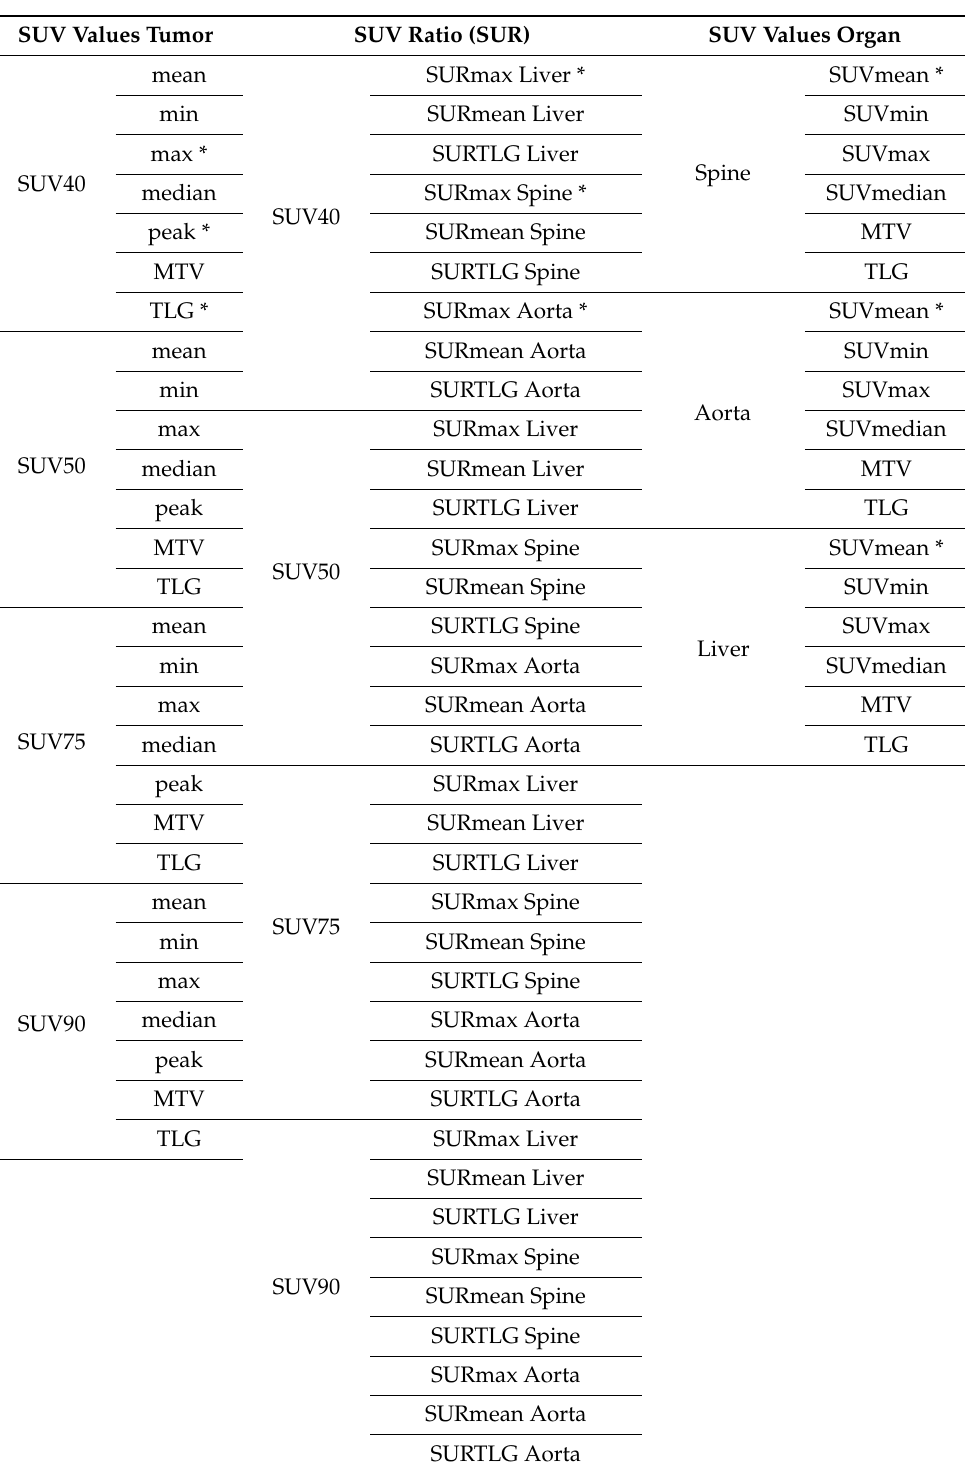
Table A2. Collected PET